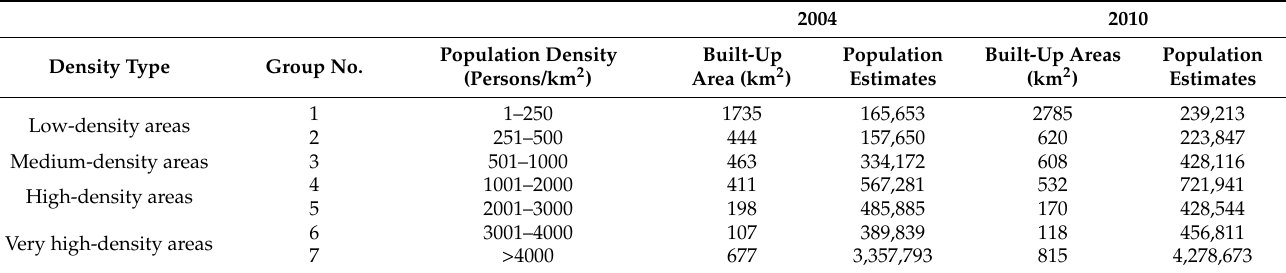
Figure 9. Spatial pattern of population estimates in Riyadh province in 2010. Table 2. Changes in population estimates and built-up areas in 2004 and 2010 in Riyadh